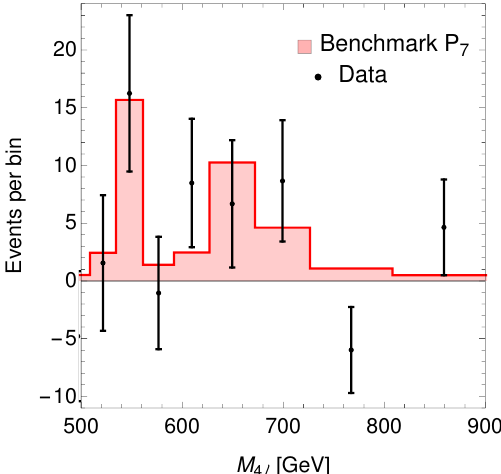
Figure 1 . Invariant mass spectrum of the best-fit points for the “best-fit benchmark point” P 7 , for details, see text. The black dots with error bars denote the difference between observed and predicted data from the four-lepton invariant mass spectrum in ref. [21].